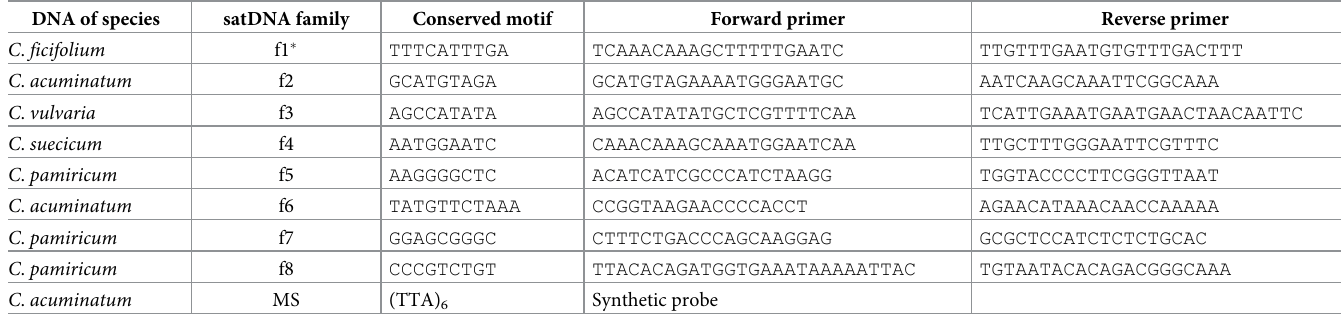
Table 2. Primers and conserved motifs for satDNA